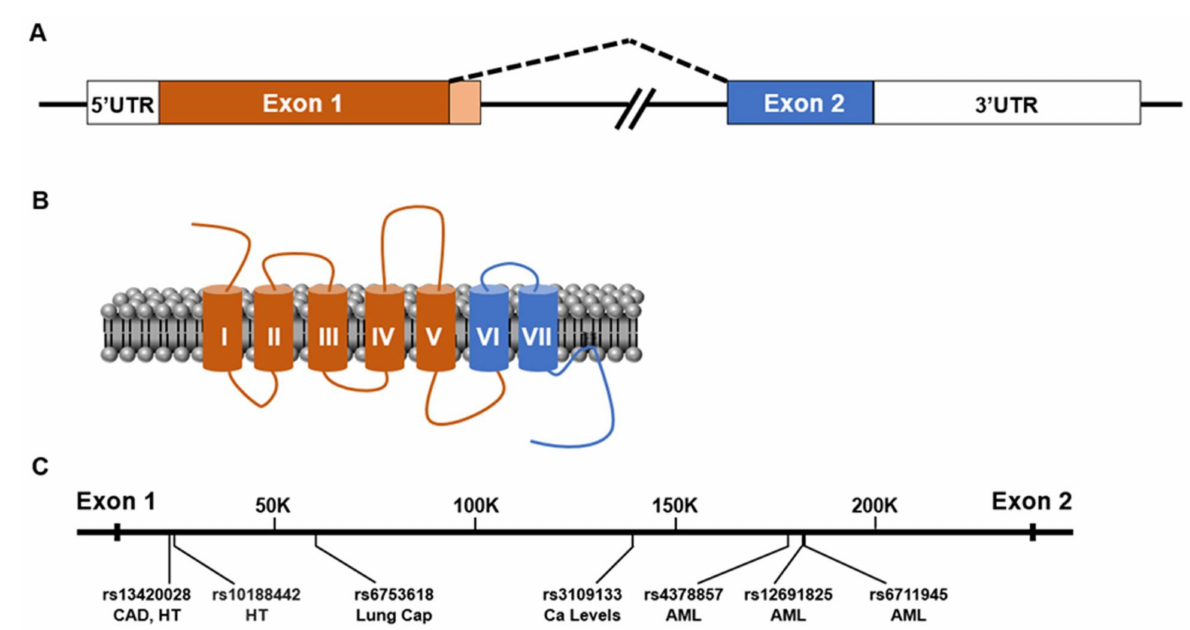
Figure 1. GPR39 gene organization and single nucleotide polymorphisms. ( A ). Diagram indicating the production of GPR39 transcripts. GPR39-1a is produced by splicing of Exon 1 (orange) and Exon 2 (blue), and GPR39-1b is produced by transcriptional intronic read-through of Exon 1 (light orange) that contributes an alternative carboxy terminus sequence. ( B ). Illustration of GPR39 protein as a seven transmembrane protein with color coding of exon contribution to the protein (orange, Exon 1 and blue, Exon 2). ( C ). Diagram of single nucleotide polymorphisms of GPR39 associated with phenotypes, coronary artery disease (CAD), hypertension (HT), lung capacity (Lung Cap), calcium levels (Ca levels), and acute myeloid leukemia